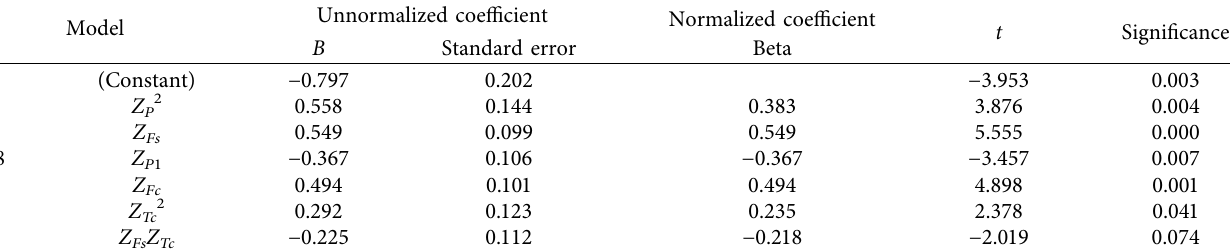
Figure 5: Histogram and P–P diagram of simulation results. (a) Histogram. (b) P–P figure. Table 5: Coefficients of the relevant